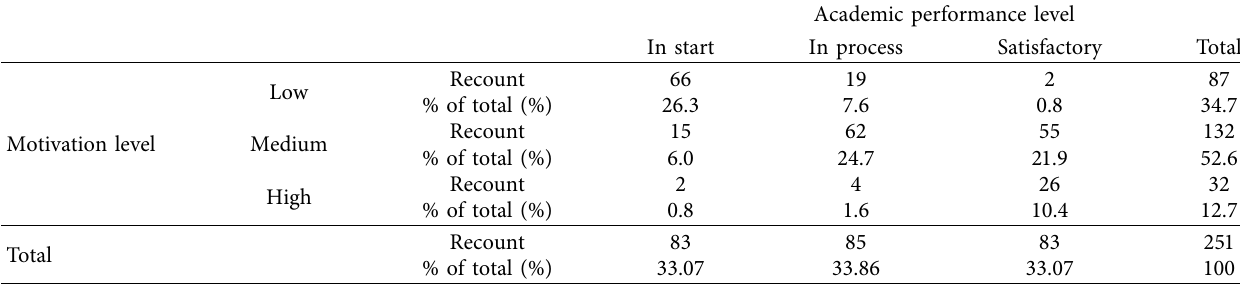
Table 6: Crossing between academic performance in mathematics and motivation.